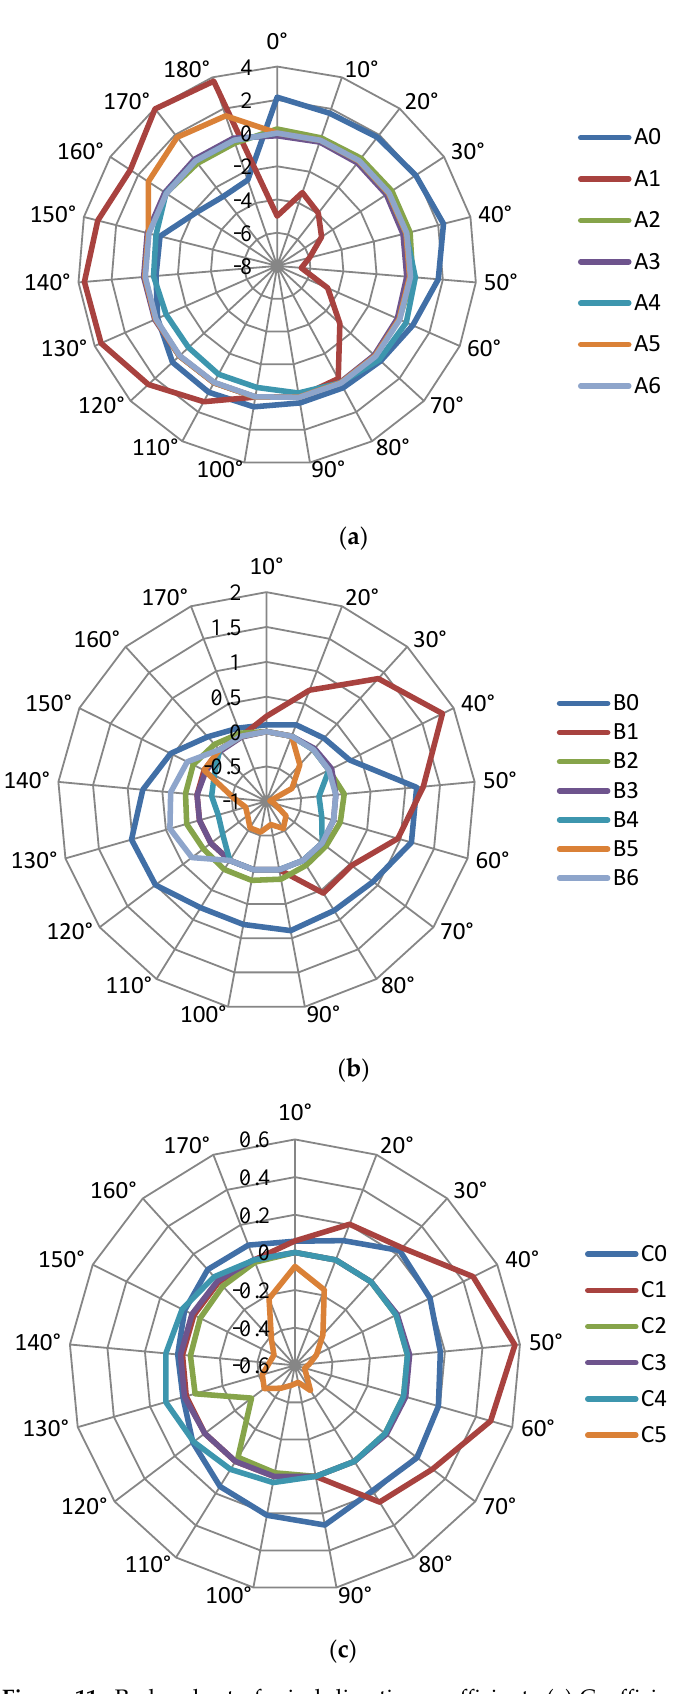
Figure 11. Radar chart of wind direction coefficient. ( a ) Coefficient 𝐴 𝑖 , ( b ) coefficient 𝐵 𝑖 , and ( c ) coefficient 𝐶 𝑖 .